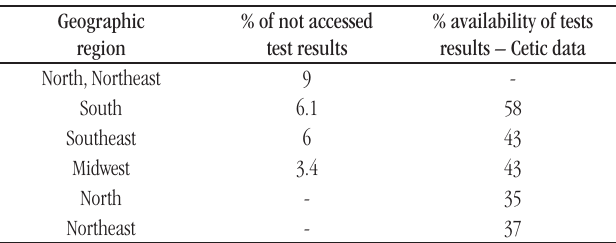
Cetic: Centro Regional de Estudos para o Desenvolvimento da Sociedade da